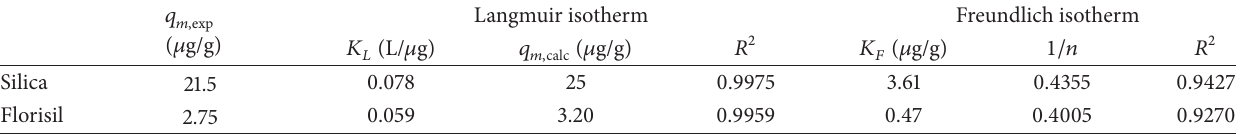
Table 4: Parameters of Langmuir and Freundlich isotherms for the adsorption of As(V) onto impregnated silica and florisil. 𝑞 𝑚, exp ( 𝜇 g/g) 𝐾